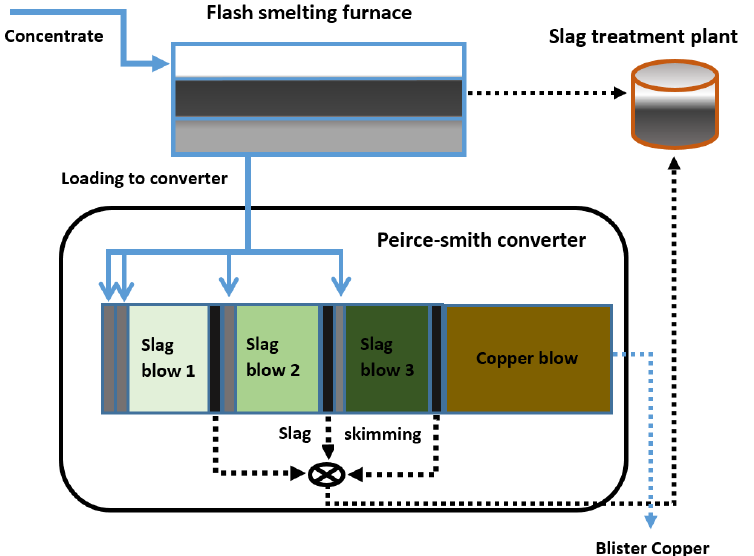
Figure 2. PSC operations